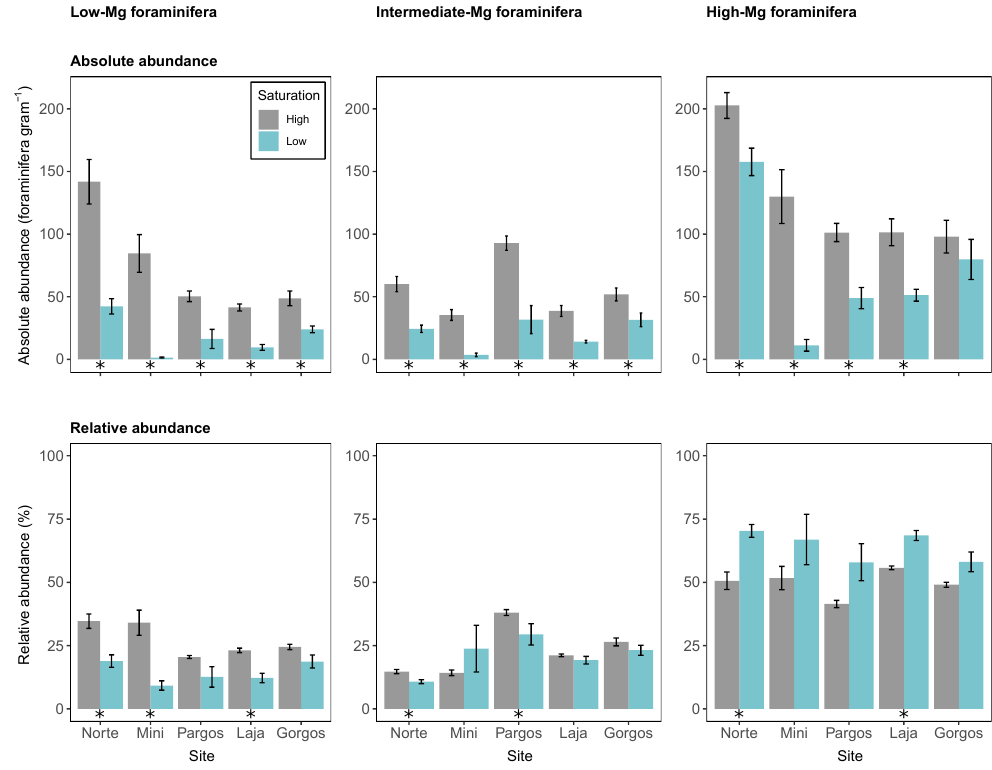
Figure 5. Absolute abundance (specimens per gram of sediment) and relative abundance (percentage) of foraminifera with different magne- sium content tests. Data are represented in mean ± SE ( n = 5). The asterisk demarks a significant difference ( p< 0 . 05) in abundance between paired springs and controls at each site, according to Mann–Whitney rank sum